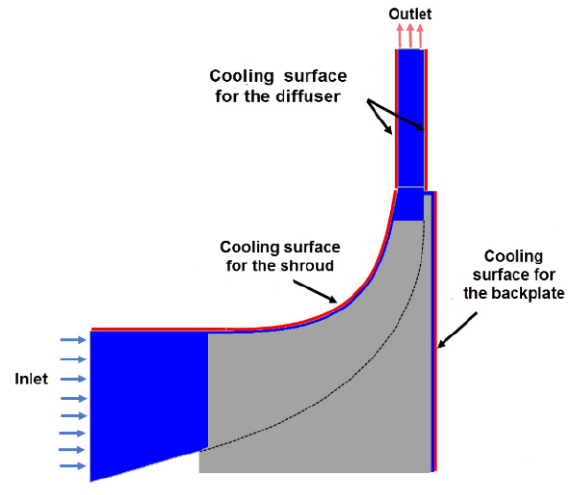
Figure 1 . Cooling walls in the centrifugal compressor. Figure 1. Cooling walls in the centrifugal